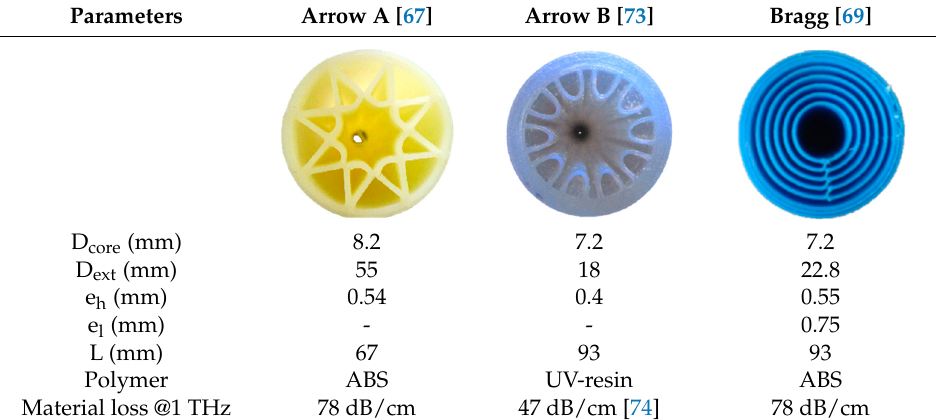
Table 2. Parameters of the 3D printed fibers [67,69,73,74].